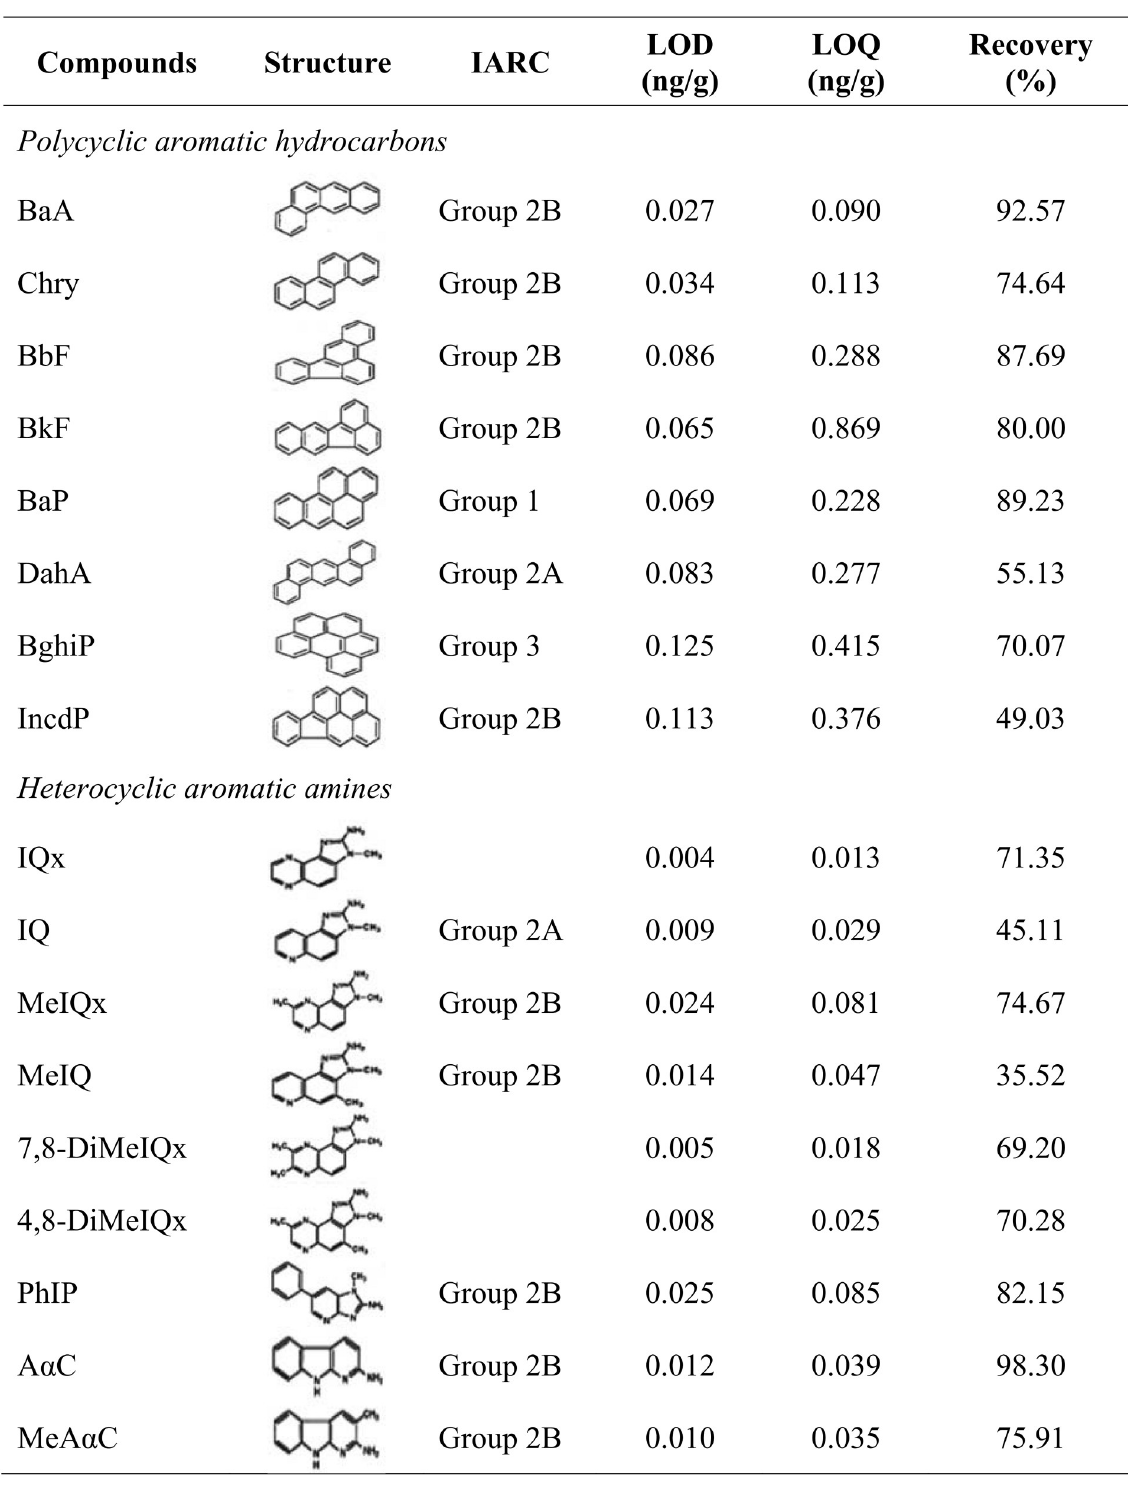
PLOS ONE | https://doi.org/10.1371/journal.pone.0227508 January 14,